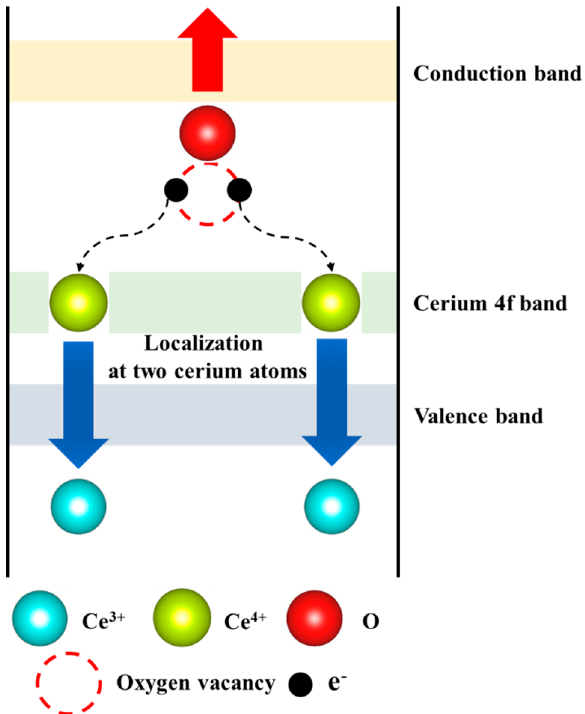
Figure 6. Schematic process of oxygen vacancy formation in tetravalent cerium oxide.